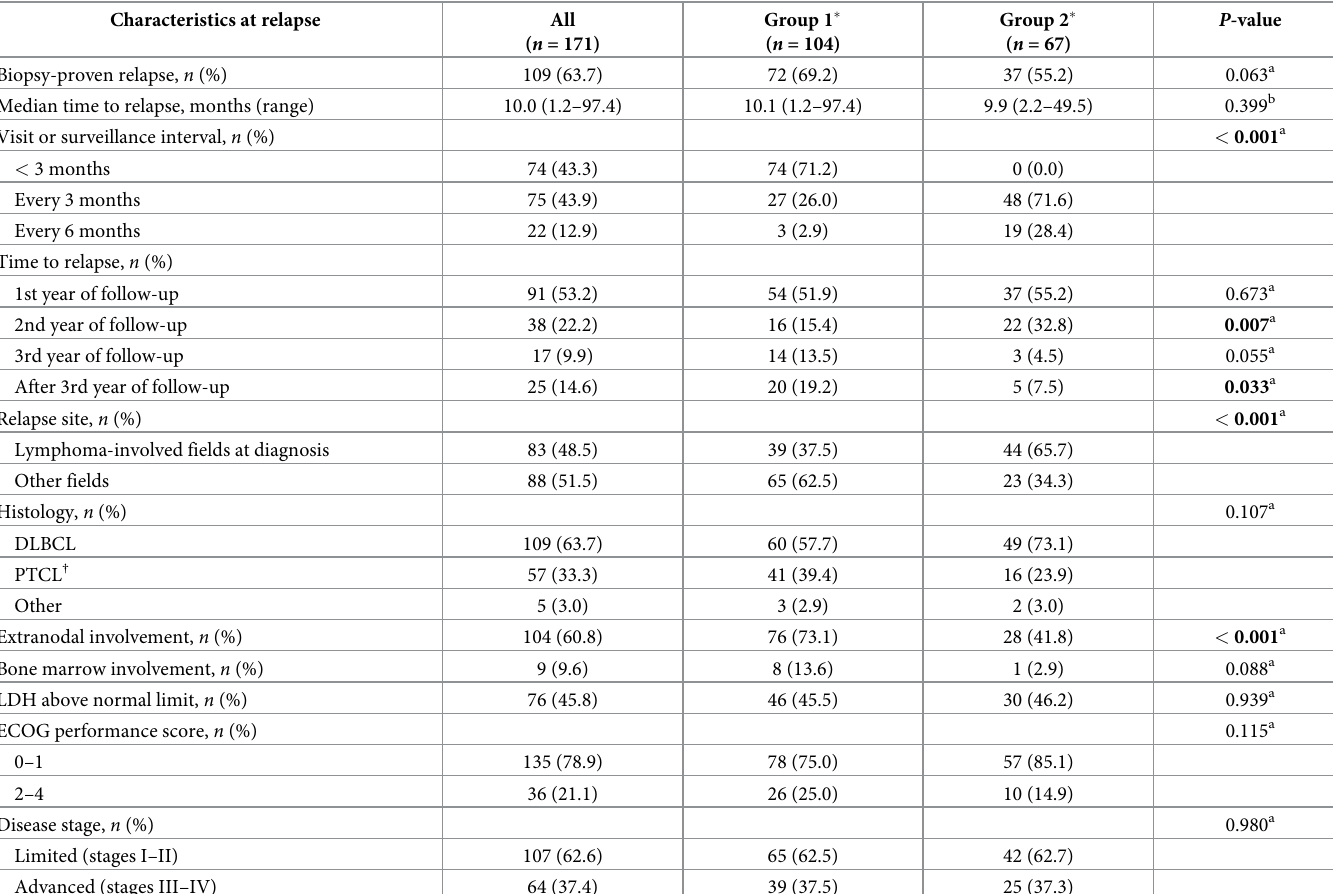
Table 2. Characteristics at relapse according to method of detection in relapsed aNHL patients after CR1. Characteristics at